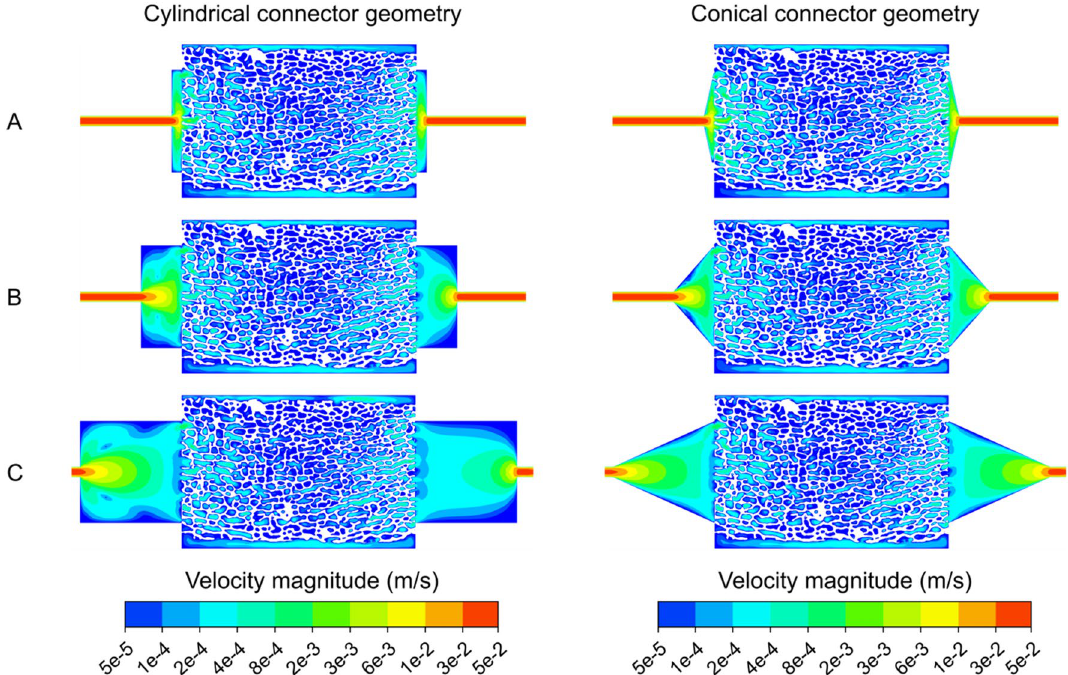
Figure 4. Numerically determined velocity magnitudes (logarithmic scale) in a sectional plane of the bioreactor-scaffold system with respect to the connector geometries and lengths ( A ) L = 1 mm, ( B ) L = 4